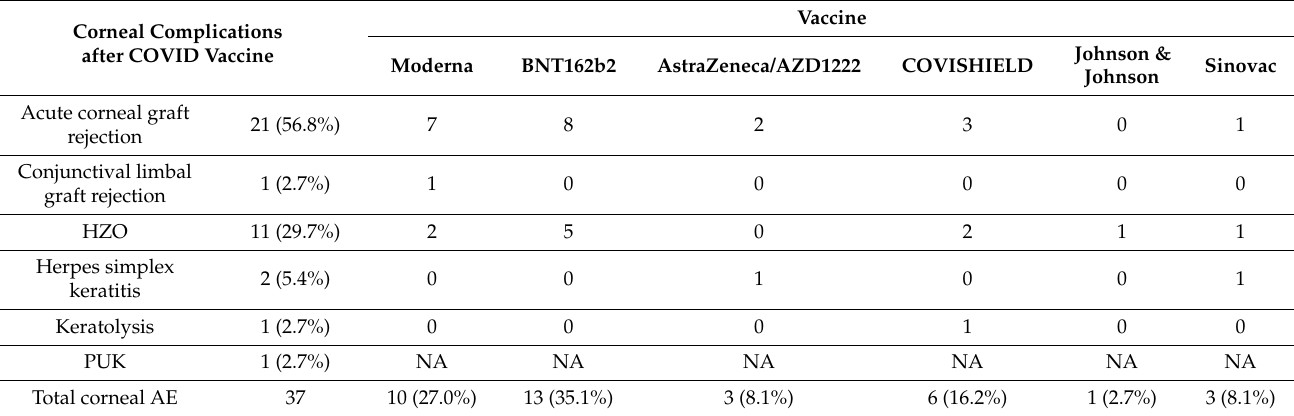
Table 2. Summary of corneal complications after COVID-19